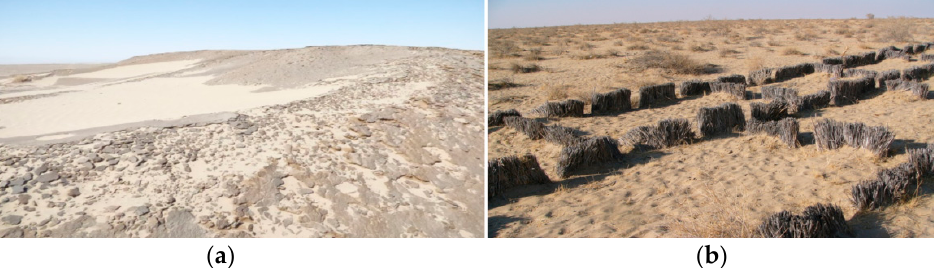
Figure 6. ( a ) Oil mulch application for dune stabilization in Sistan Plain (Iran); ( b ) Sand catchers for sand surface stabilization in the eastern Karakum Desert, Turkmenistan (photos: Ch. Opp).